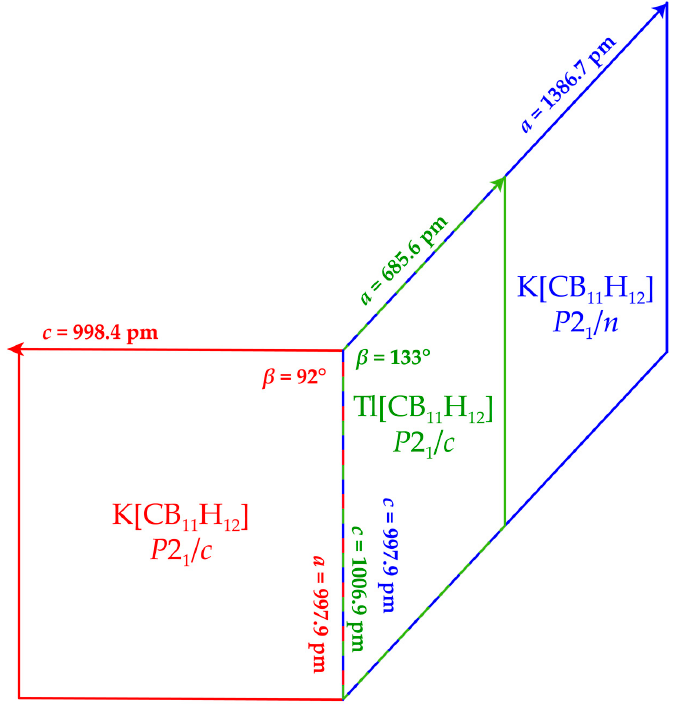
Figure 7. Symmetry relationship of the monoclinic unit cells of the literature-known K[CB 11 H 12 ] [2] (red and blue) and the new Tl[CB 11 H 12 ] (green).